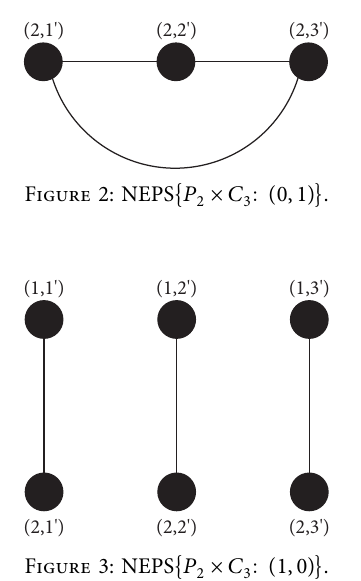
Figure 3: NEPS P